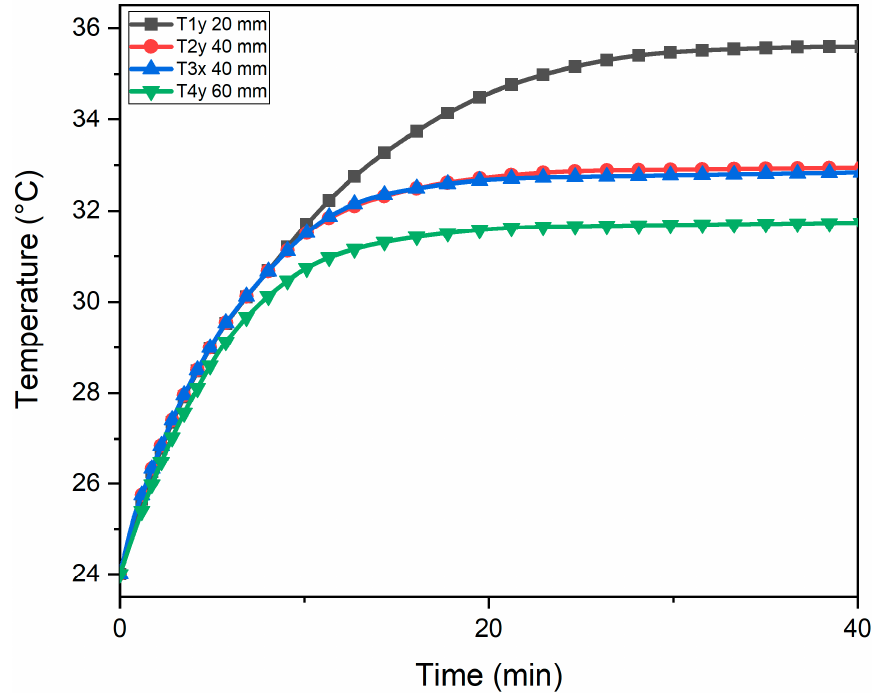
Figure 12. Temperature profile along the x- and y-axis for reverse flow configuration with power input of 30 W.